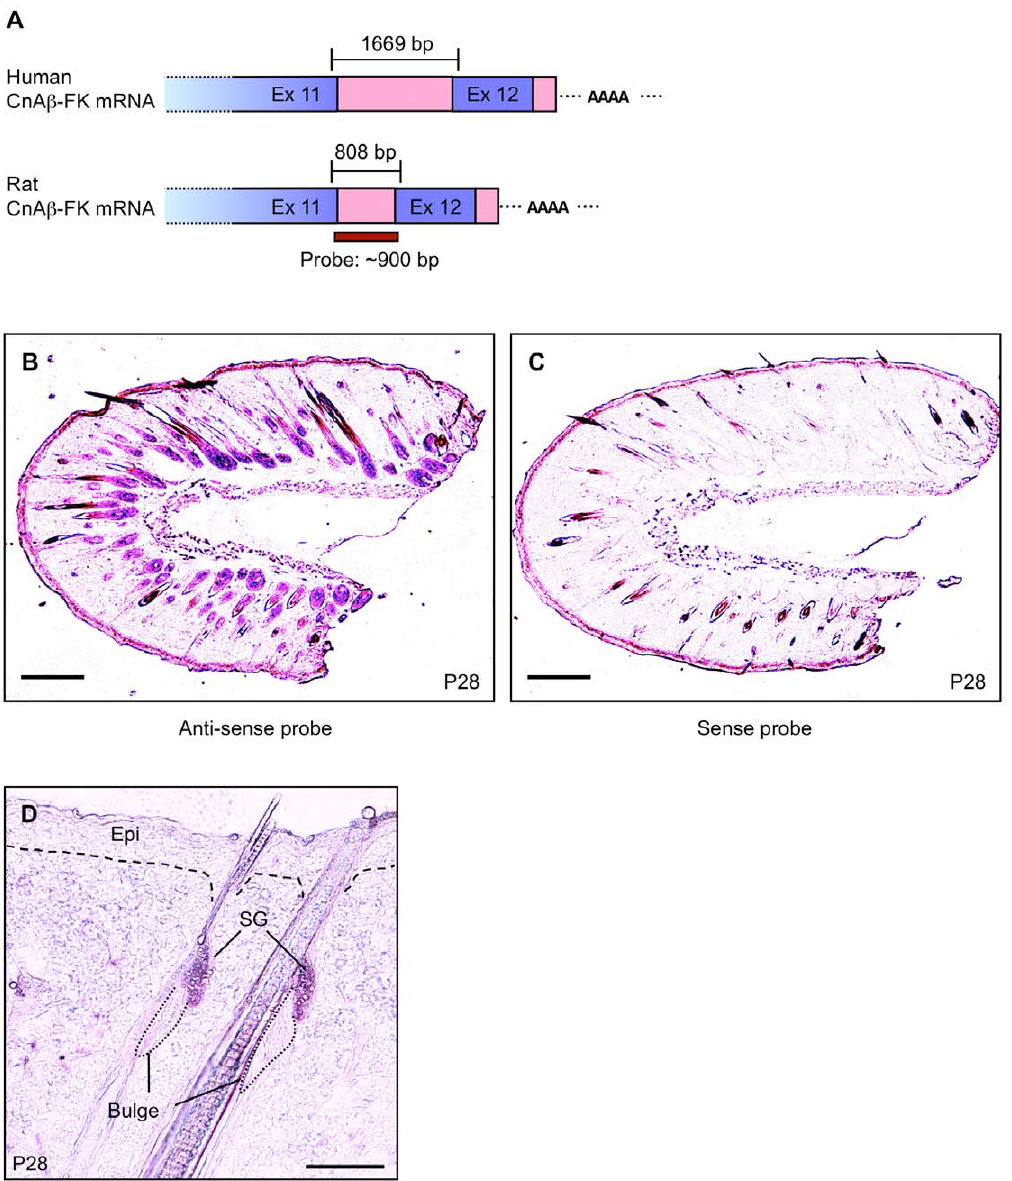
Figure 2. Localization of CnAß -FK mRNA in rat skin. (A) Schema of sense and anti-sense probes used for in situ hybridization (ISH). The probes correspond to the full sequence of intron 11 and are specific for CnAß-FK mRNA. Sense probes were used as the negative control. (B and C) Expression of CnAß-FK mRNA in rat skin. Skin sections from the parietal region were prepared from male Wistar rat (postnatal day 28, corresponding to the late phase of the second anagen). (D) Higher magnification micrograph to show the mRNA expression in epidermais and SG. Epi, epidermis; SG, sebaceous gland. Scale bars in B and C, 1 mm; in D, 50 m m.